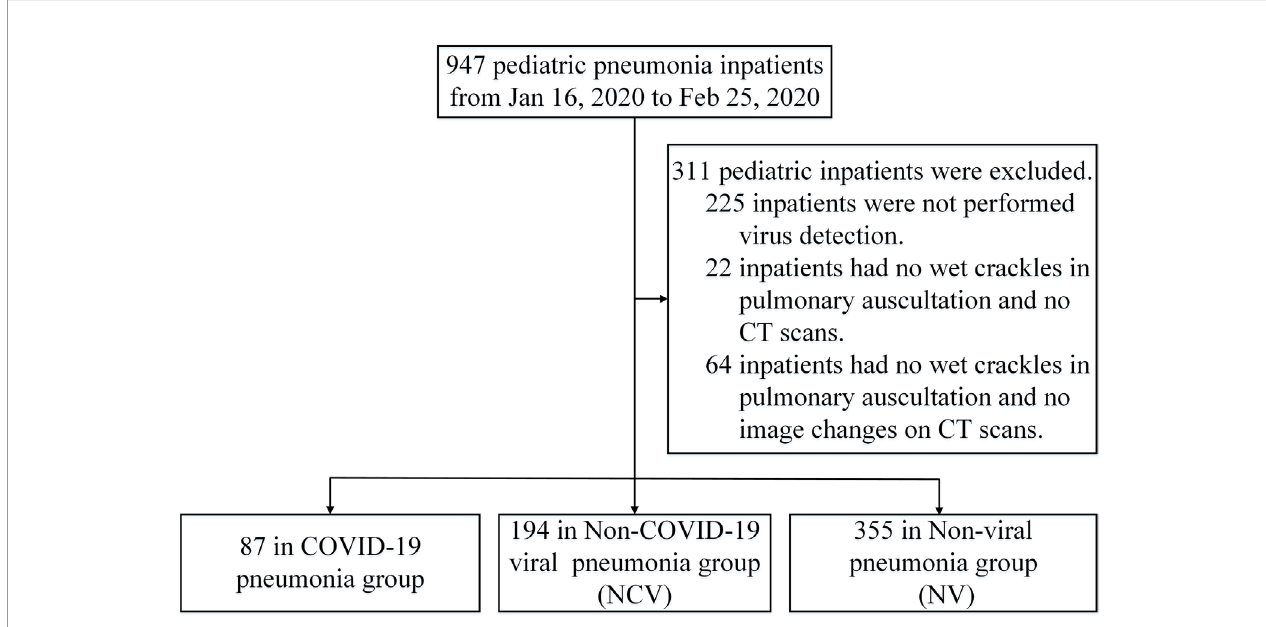
FIGURE 1 | Study pro fi